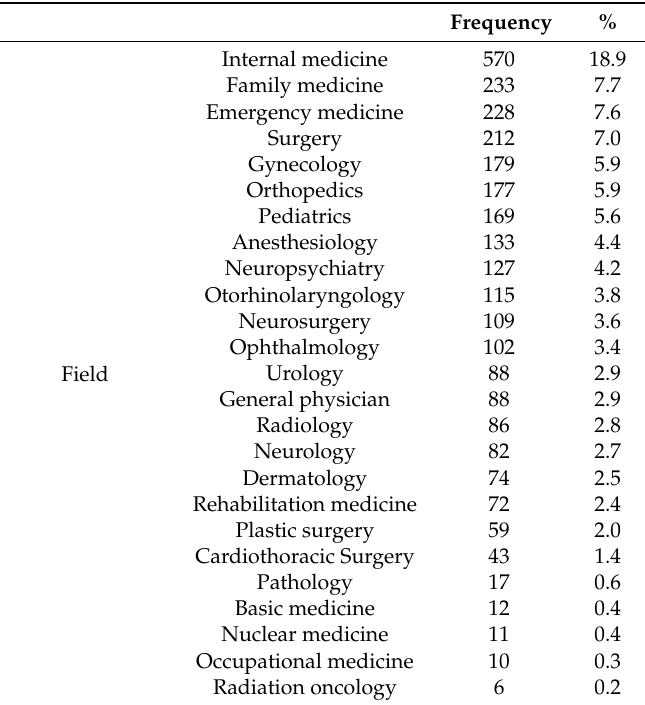
Table 2. Analysis of the medical fields of the survey